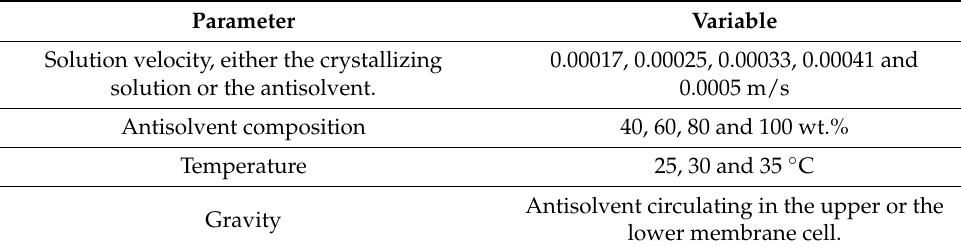
Table 2. Operating conditions used in the current study of